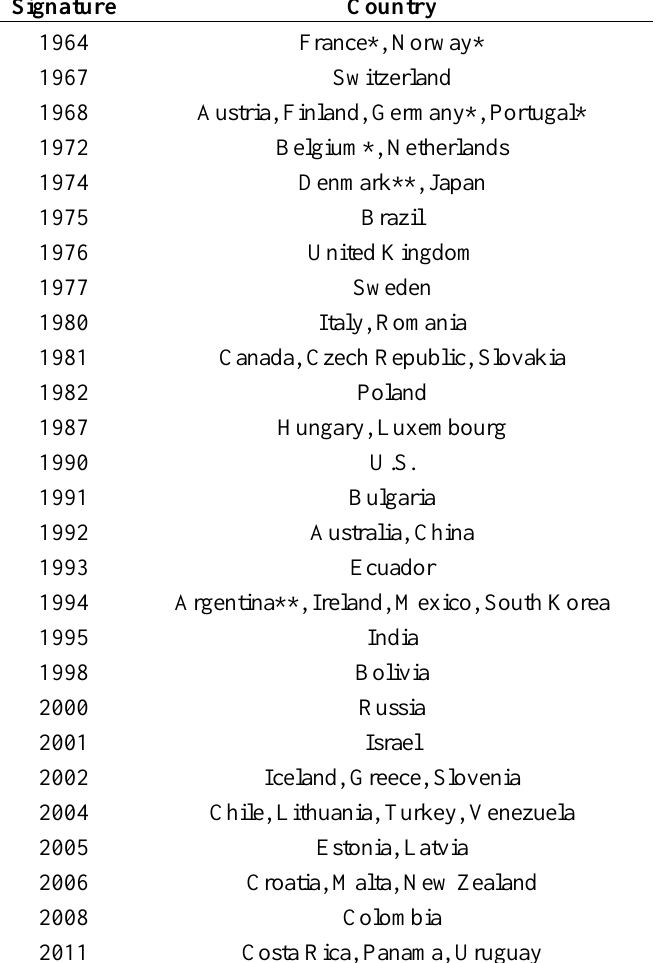
Table 1 : Spanish Double Taxation Treaties: